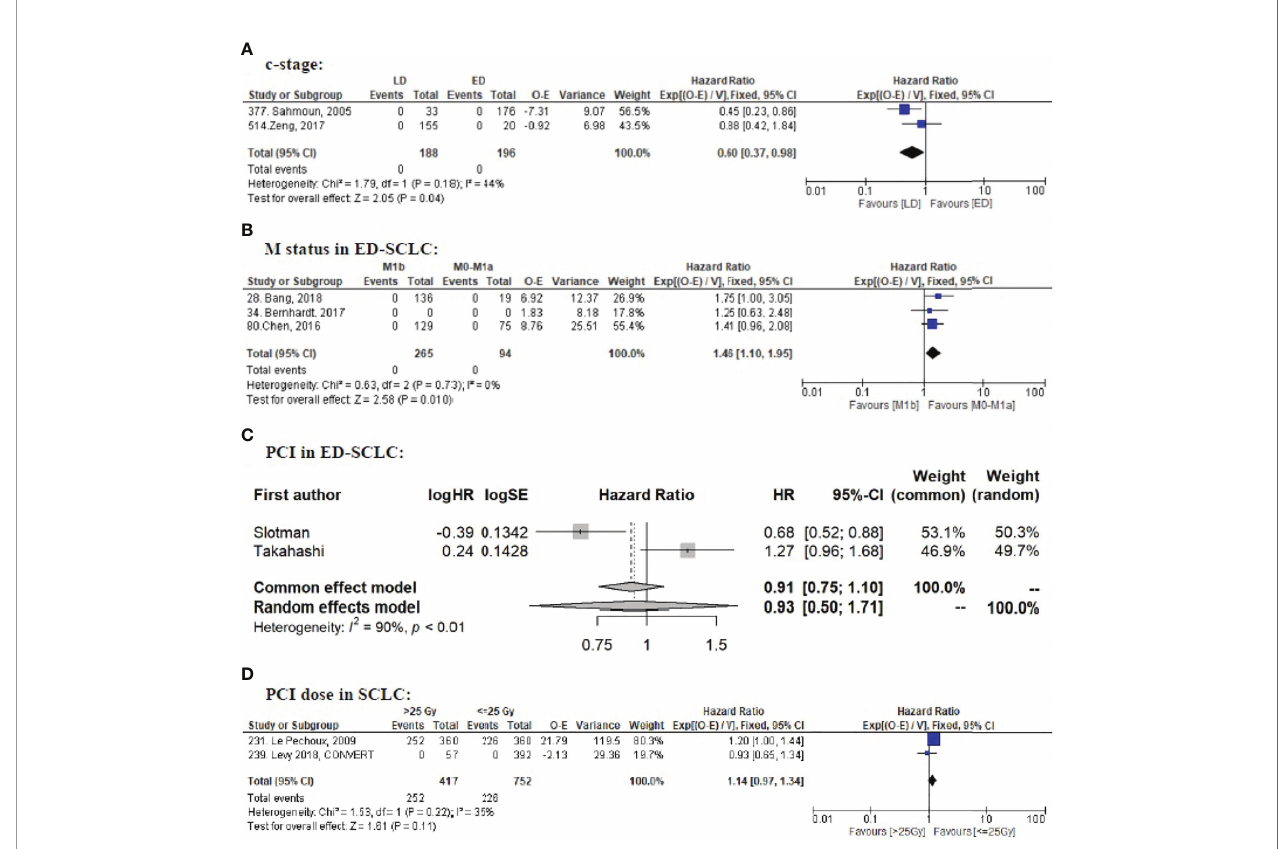
FIGURE 4 | Forrest plots for OS: (A) c-stage; (B) M status in ED-SCLC; (C) PCI in ED-SCLC; (D) PCI dose in SCLC. OS, overall survival; LD, limited-stage disease; ED, extensive-stage disease; SCLC, small cell lung cancer; PCI, prophylactic cranial irradiation; O, observed events; E, expected events; V, variance; CI, con fi dence interval; HR, hazard ratio; SE, standard